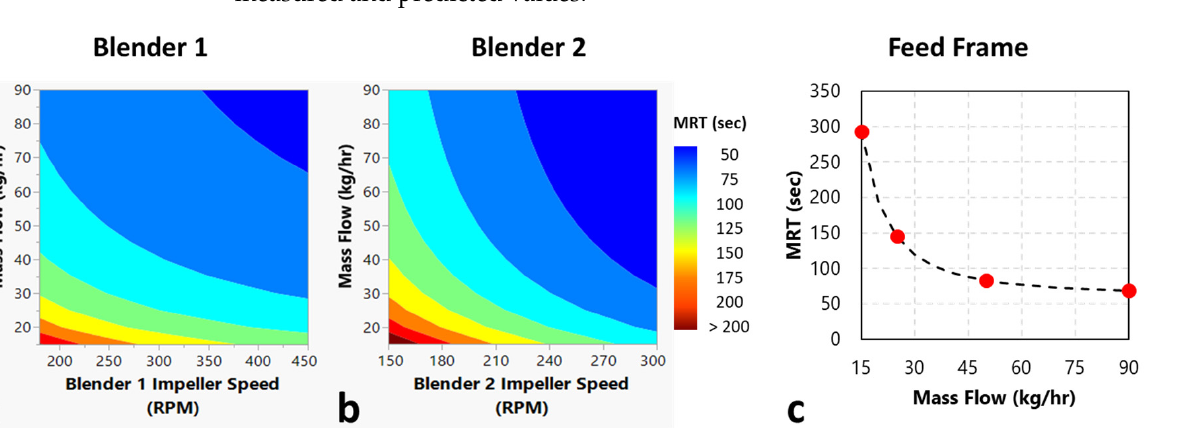
Table 5. Regressed Blender Constants for Each Blending Unit.